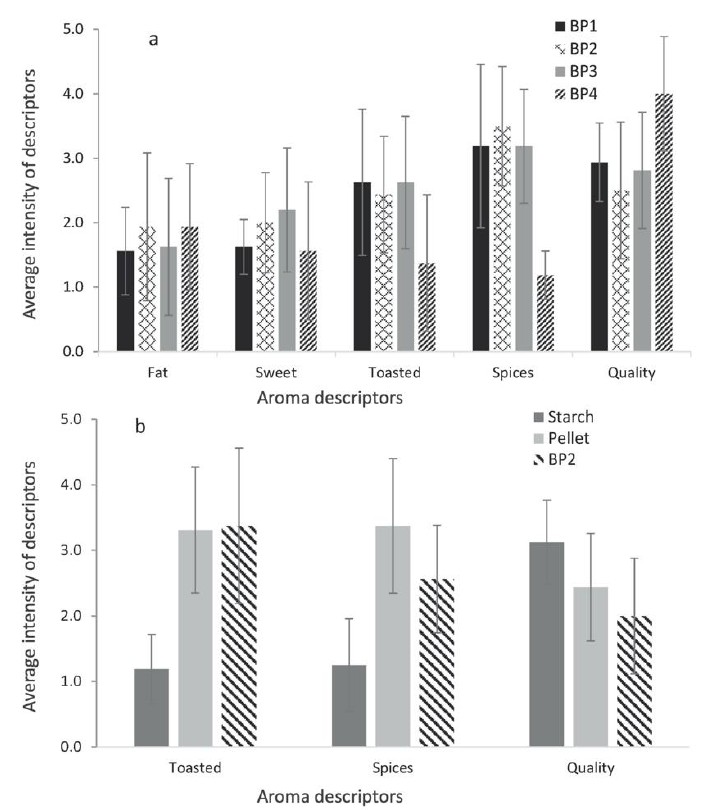
Figure 3. Bar chart of the sensory test for comparison between ( a ) 4 starch-based films (BP1, BP2,